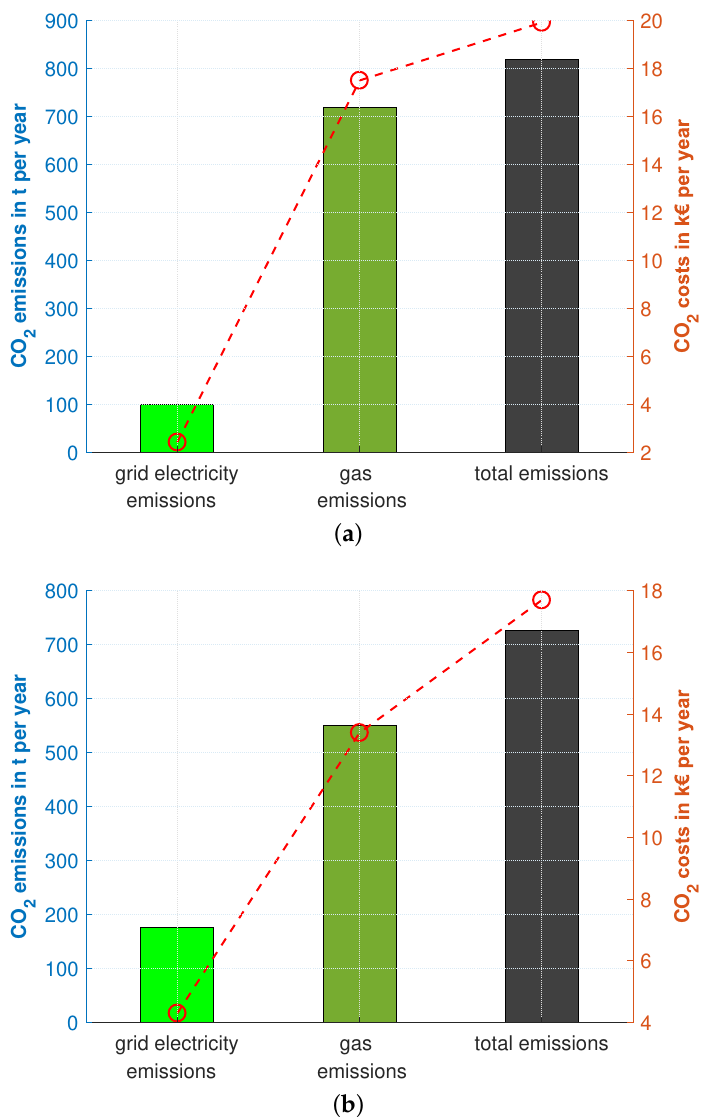
Figure 12. Resulting annual CO 2 emissions and costs for: ( a ) default contracting case; ( b ) higher emission costs of 70 e /t CO 2